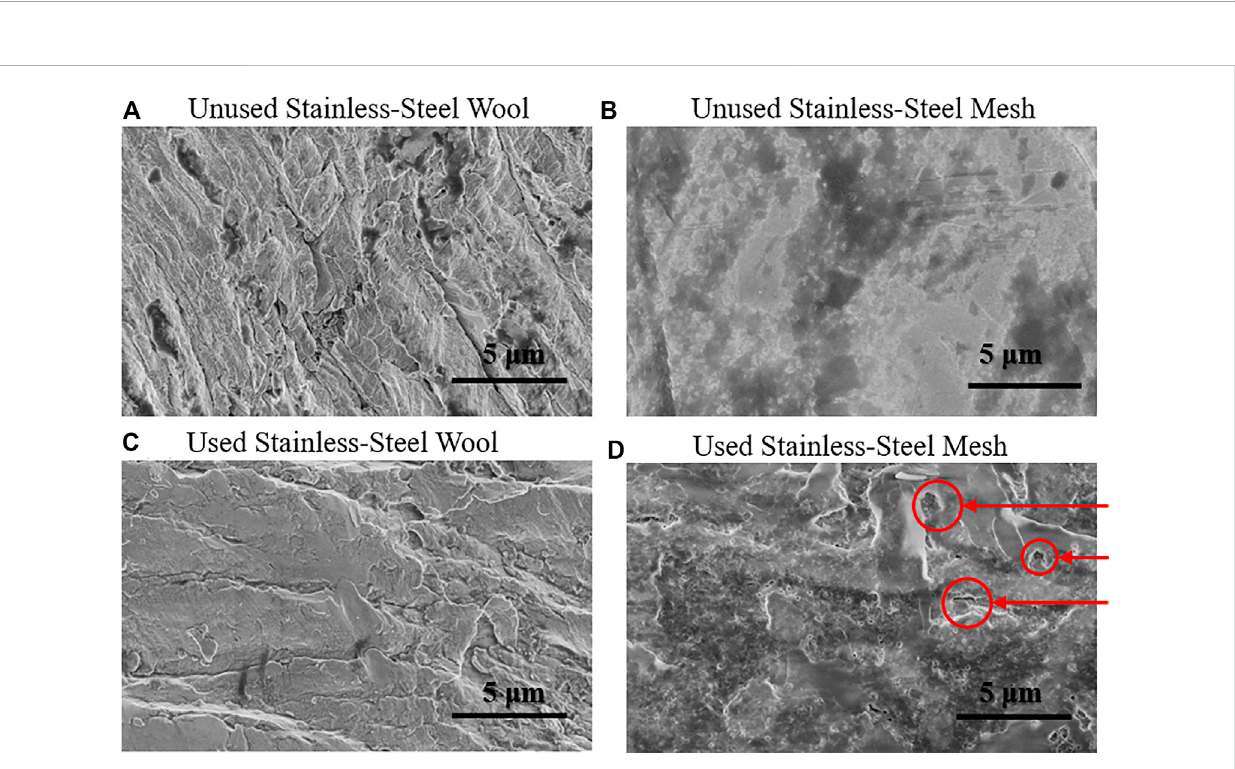
Scanningelectronmicrographsofmetallicanodematerials. (A) Unusedstainless-steelwool (B) Unusedstainless-steelmesh (C) Usedstainless-steel wool (D) Used stainless-steel mesh. Arrows in (D) indicated the morphological changes (black craters with white borders) similar to pitting as compared to (B)